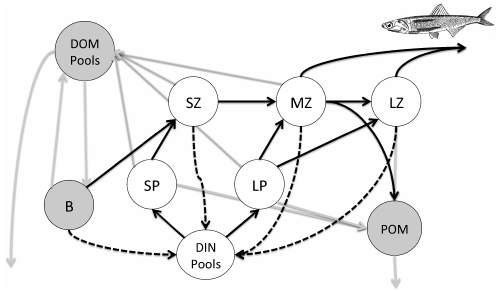
Figure 1. Simplified schematic of planktonic food web dynamics within COBALT. DIN Pools – diverse pools of dissolved organic nutrients (e.g., NH 4 , NO 3 , Fe, PO 4 , SiO 4 ) ; SP – small phytoplank- ton; LP – large phytoplankton; SZ – small zooplankton (i.e., micro- zooplankton); MZ – medium zooplankton (i.e., small to medium- bodied copepods); LZ – large zooplankton (i.e., large copepods and euphausiids/krill); DOM Pools – dissolved organic matter pools of various lability; B – free-living heterotrophic bacteria; POM – par- ticulate organic material. Fish enter the model as a closure term on MZ and LZ. Arrows indicate exchange of material between groups. Dashed arrows are reserved for respiration/remineralization of or- ganic matter. Downward arrows for POM indicate sinking. A down- ward arrow is also shown for DOM to indicate that the downward mixing of long-lived DOM can also create significant export of or- ganic material from the euphotic zone in the